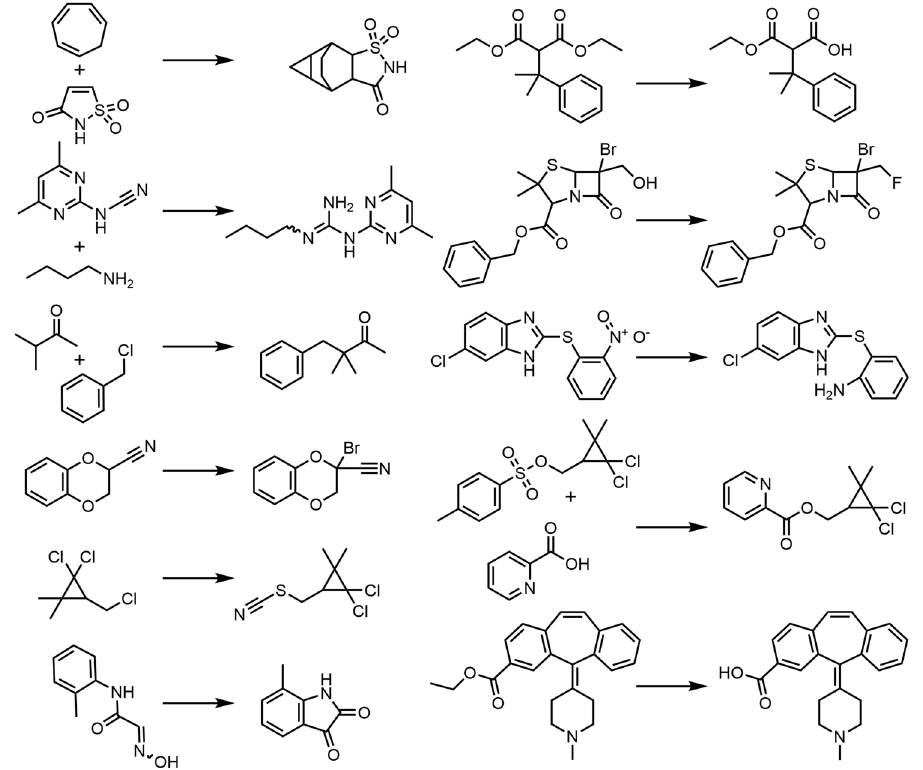
Figure 1. Illustrative reactions from the training set. A small sample of eleven reactions chosen at random from the set of 450,000 reactions analyzed by machine learning methods. The reactions are diverse and span different types of chemistries. Shown here are: cycloaddition, synthesis of guanidines, alkylation of ketones, alpha-bromination of nitriles, substitution of primary alkyl chlorides with thiocyanate anion via S N 2, synthesis of isatins, ester hydrolysis (in two reactions), fluorination of primary alcohols, reduction of nitro compounds, and esterification of carboxylic